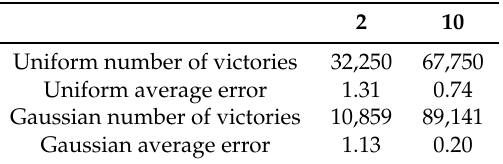
Table 4. Number of times each value of k in {2,10} produces minimal error and average error values, over 100,000 items generated according to both models. For k = 10, we only permitted scores between 3 and 6 (inclusive). If a score was below 3, we set it to be 3, and above 6 to 6.